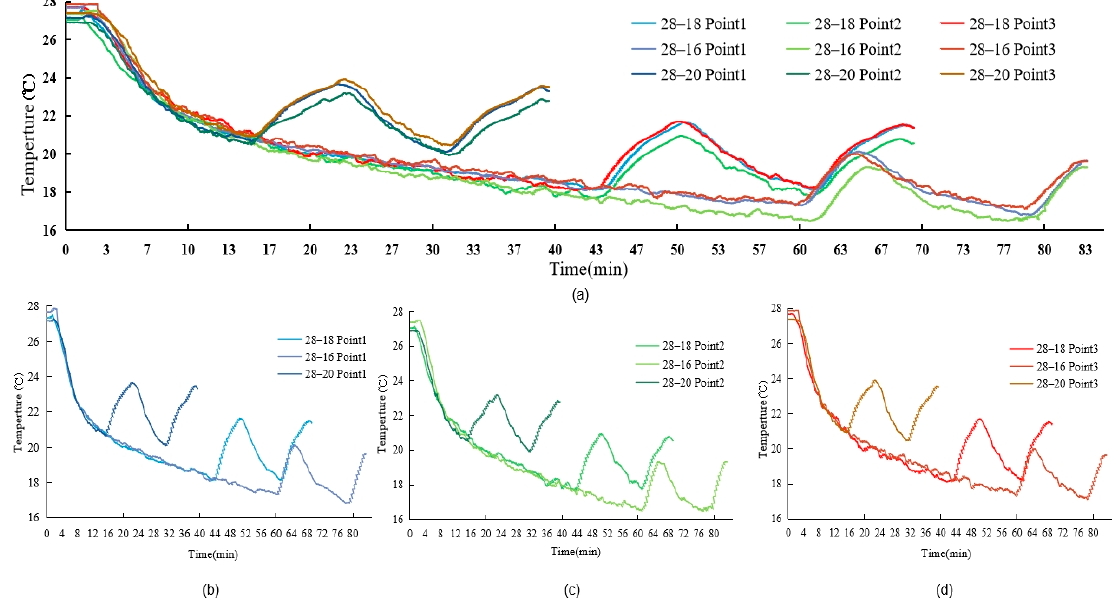
Figure 9. Temperature time series distribution of monitoring points under refrigeration. ( a ) Tem- perature distribution of three points in case1–3. ( b ) Temperature distribution of the point1 in case1–3. ( c ) Temperature distribution of the point2 in case1–3. ( d ) Temperature distribution of the point3 in case1–3.